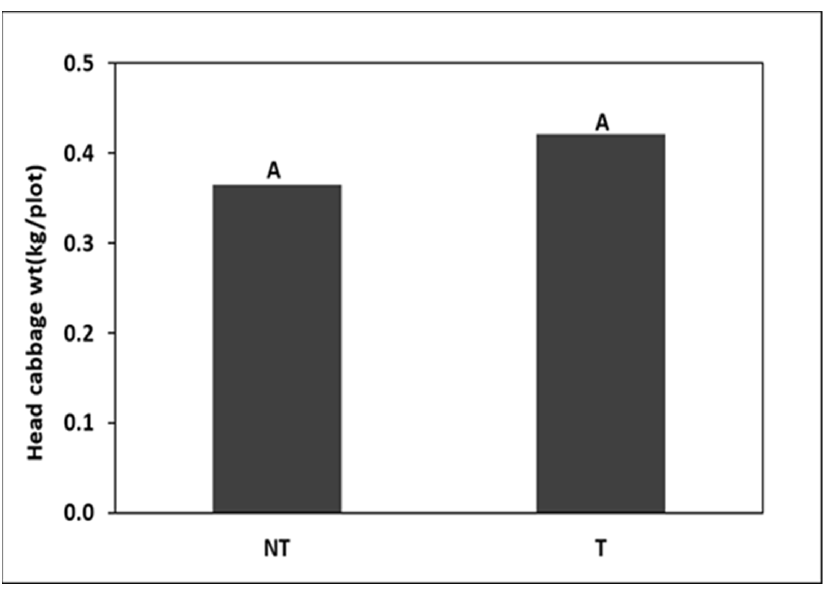
Figure 10. Effect of trap cropping on head cabbage yield in Cabbage Trial II. T = trap crop, NT = no trap crop. Means followed by the same letters are not different based on analysis of variance.